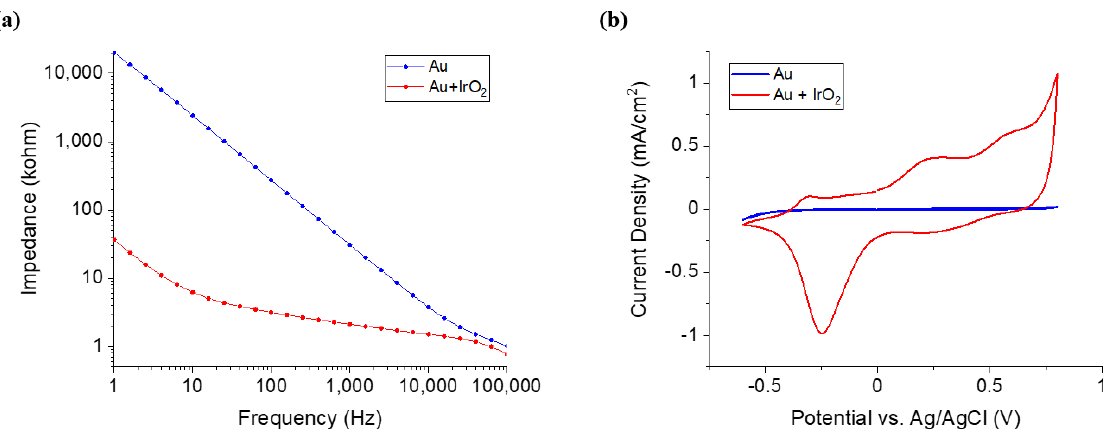
Figure 3. Characterization of DCNI (Au vs IrO 2 coating): ( a ) Impedance measurement of the DCNI and ( b ) CV test of the DCNI.